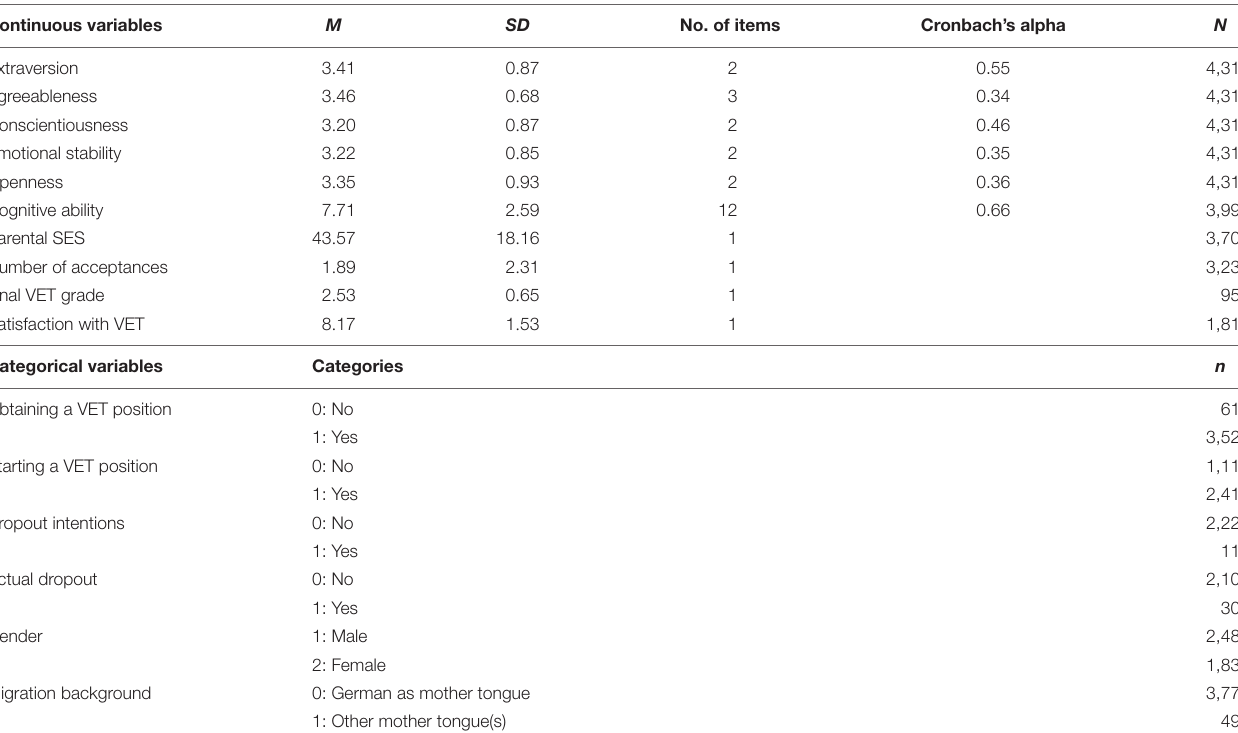
TABLE 1 | Descriptive statistics for continuous and categorical